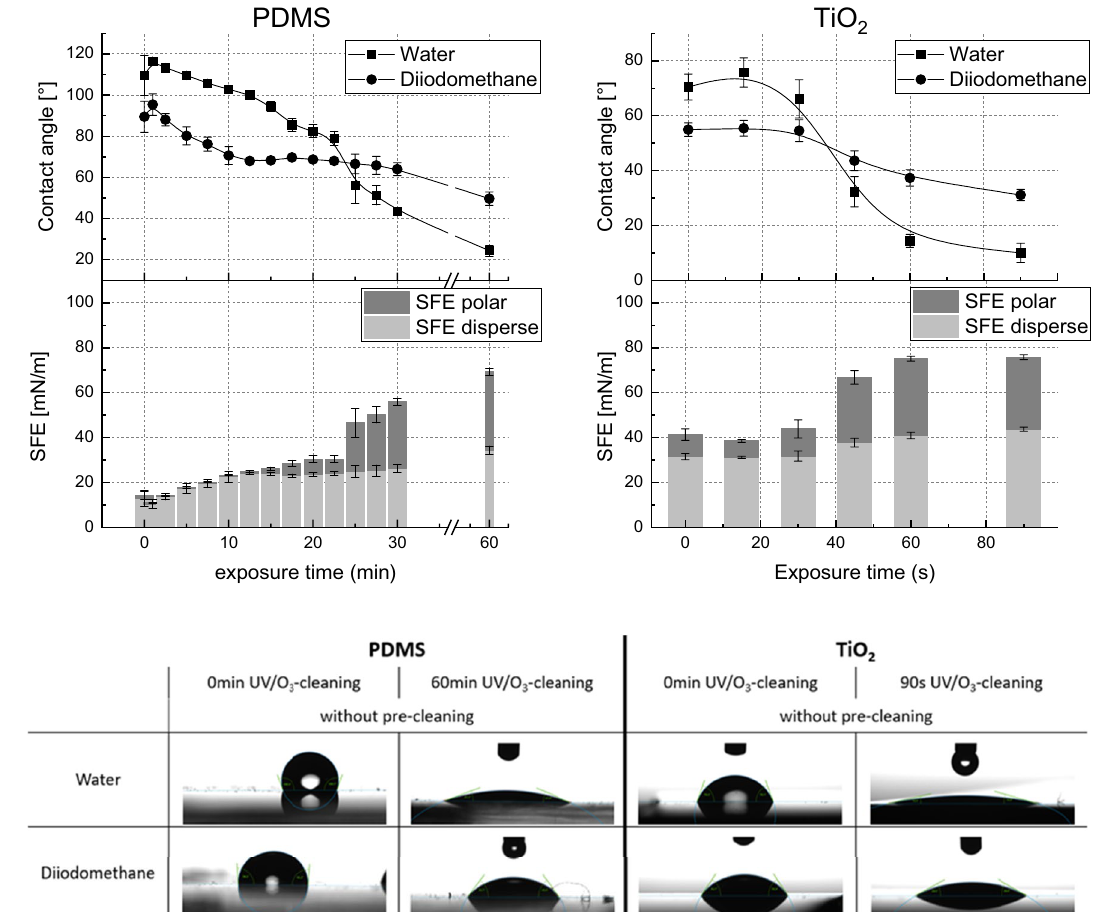
and therefore the SFE value increases. Lower row: typical pictures of the contact angles of water and diiodomethane on PDMS and TiO substrates before UV/O -cleaning and 2 3